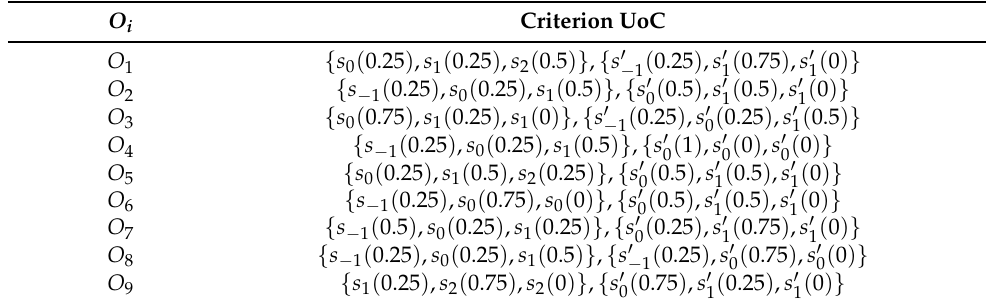
Table 13. Normalized qualitative matrix for criterion